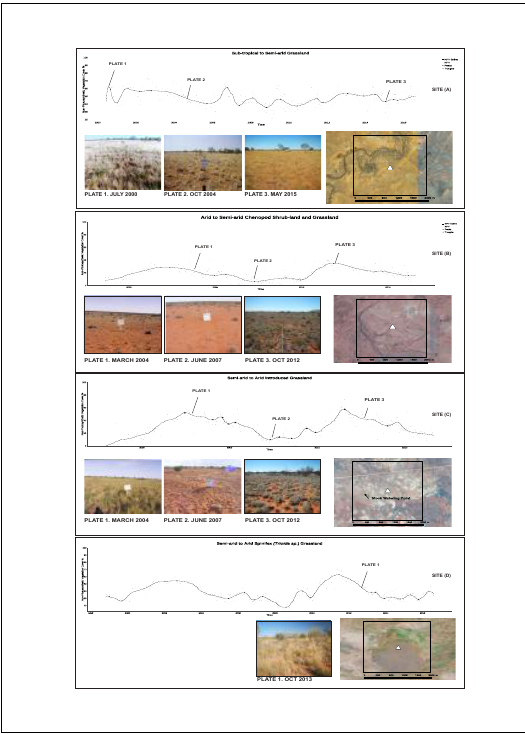
Figure 13. Field site time-series plots of the four example. Each plot illustrates each sites growth cycles, associated growth peaks and troughs, field site visit photos and the extent of each image subset.